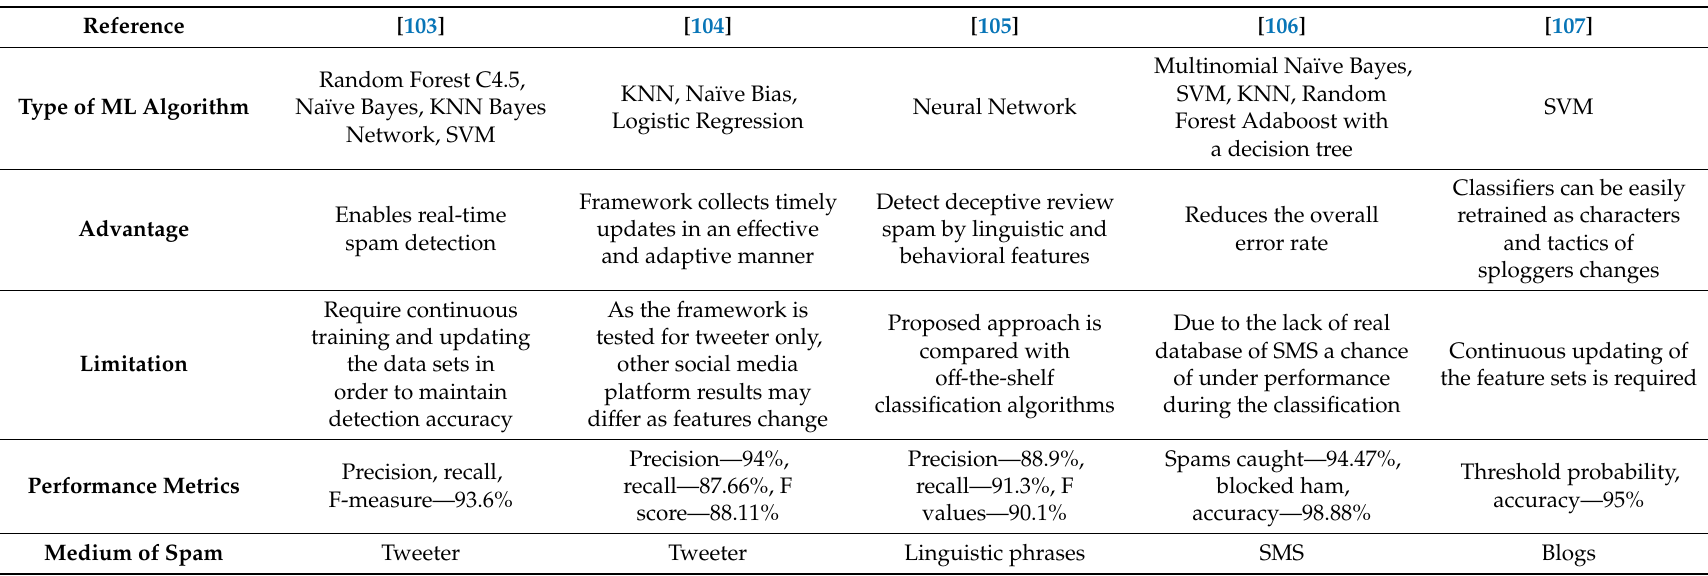
Table 8. Review of existing spam detection.